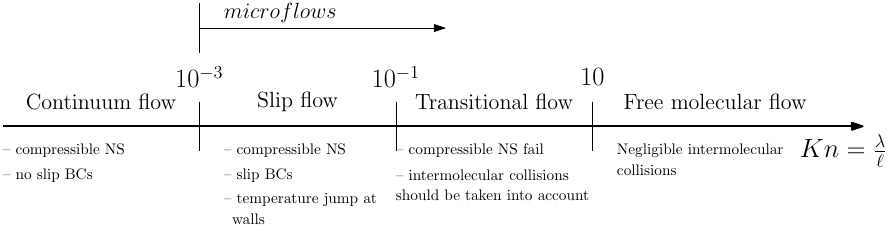
Figure 1. Different flow regimes in function of the Knudsen number Kn